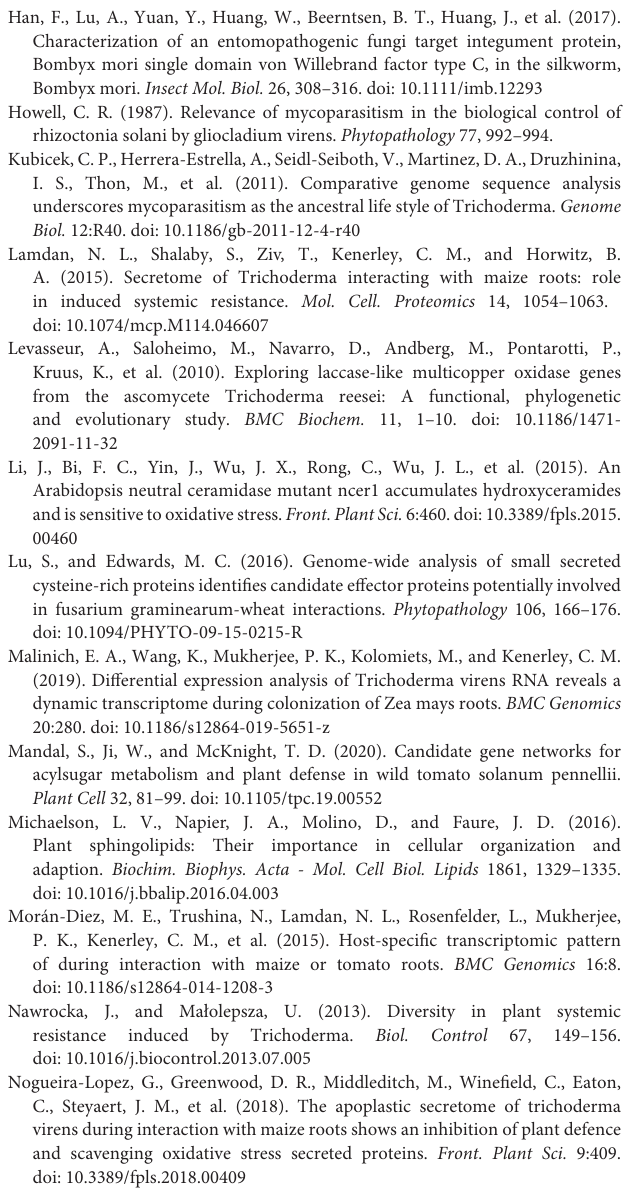
Supplementary Figure 1 | Visualization of the T. virens gene co-expression network. Each blue rectangle represents a single gene in the T. virens genome. The lines connecting genes, called edges, represent a high likelihood of co-expression. Supplementary Figure 2 | A three-dimensional plot of the top three principal components. Different colors represent different clusters as determined by the DBSCAN algorithm. Many clusters are not visible due to the density of the data